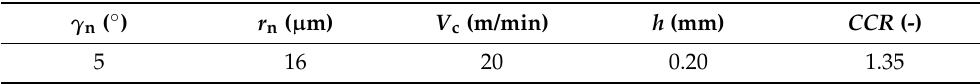
Table 7. Optimal cutting conditions for minimizing the CCR.